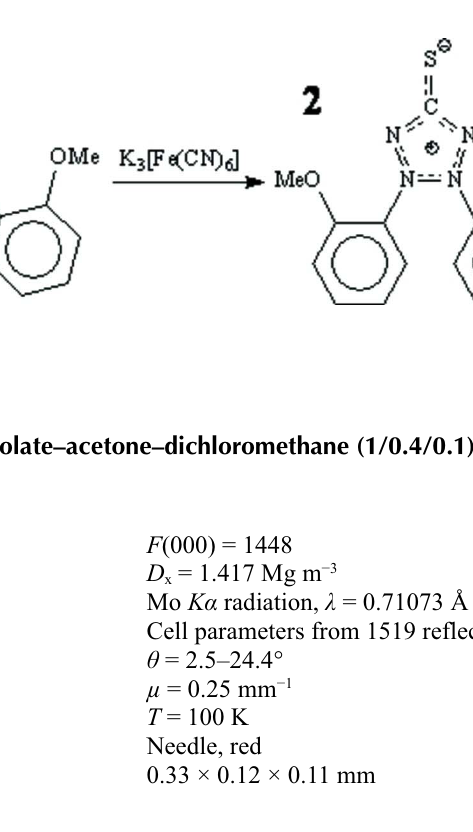
View of (2) with 30% probability displacement ellipsoids. Accented lettering indicate atoms generated by symmetry (2 - x , y , 3/2 - z ).